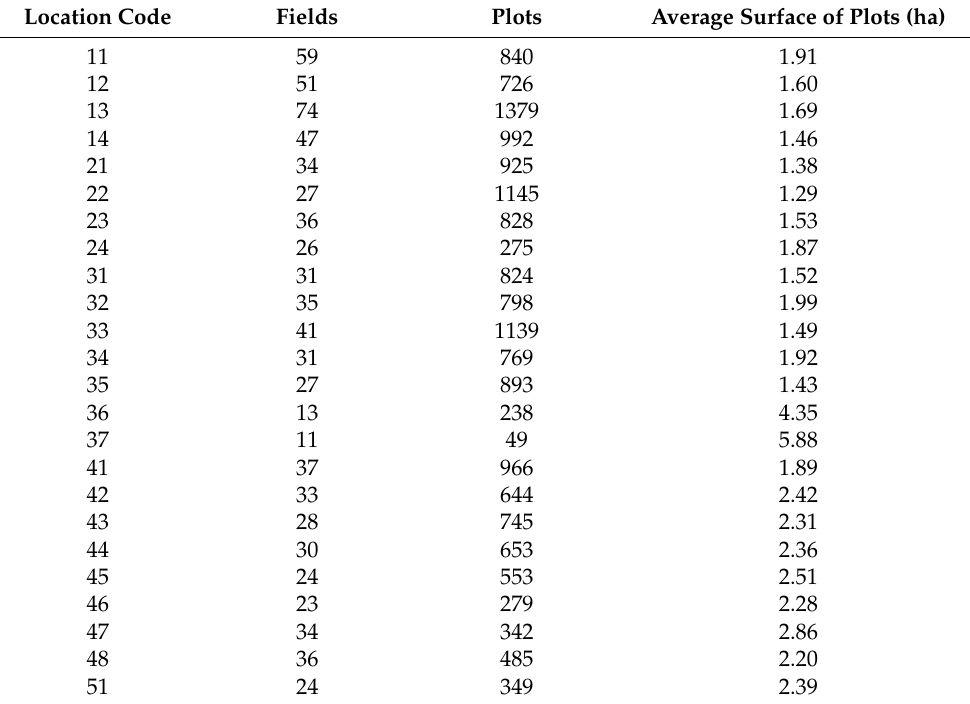
Table 1. Number of fields and plots by location and average surface plots. Location Code Fields Plots Average Surface of Plots (ha)